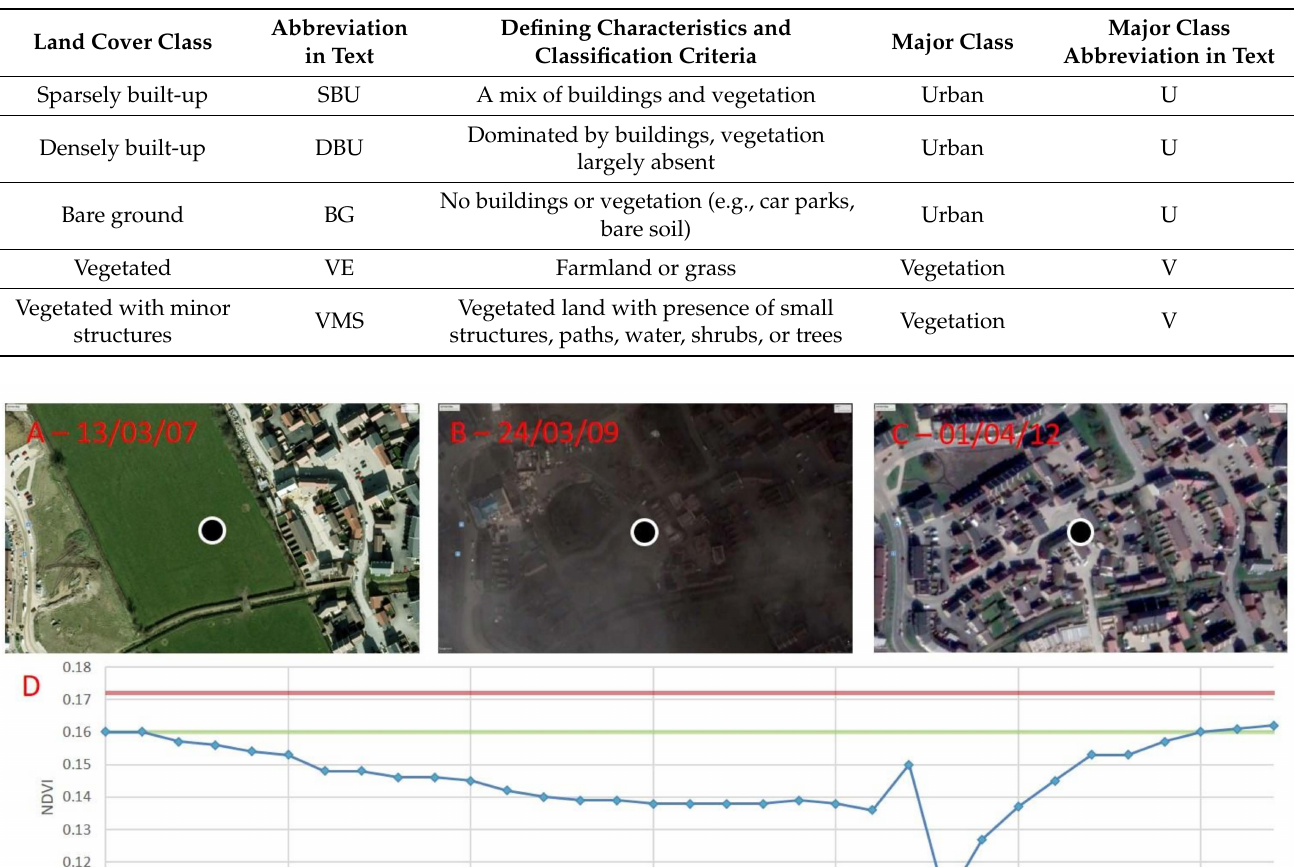
Table 2. Land cover classes used in the study.